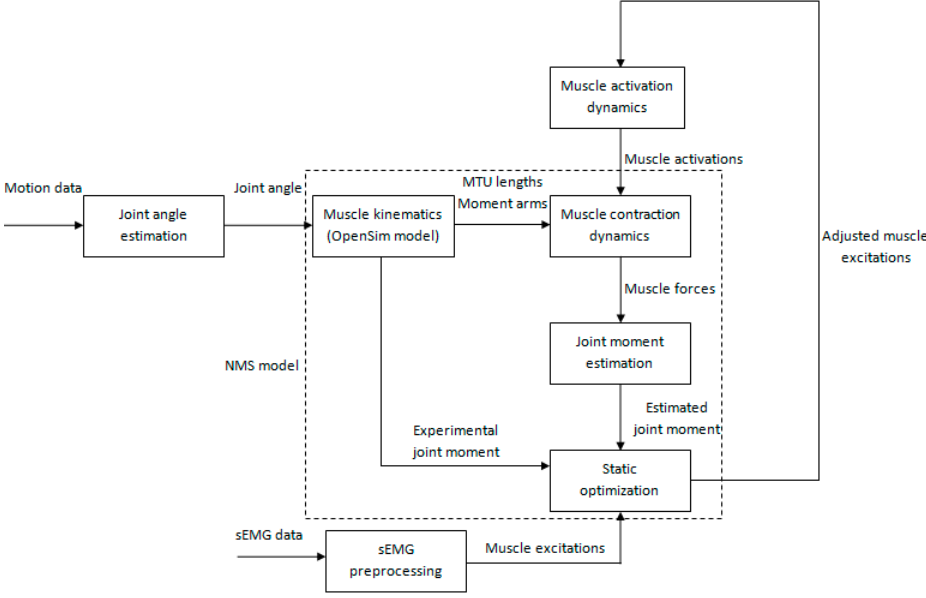
Figure 5. The flowchart of simulation process. Static optimization is used to adjust muscle excitations to make the joint moment estimation more close to reality.